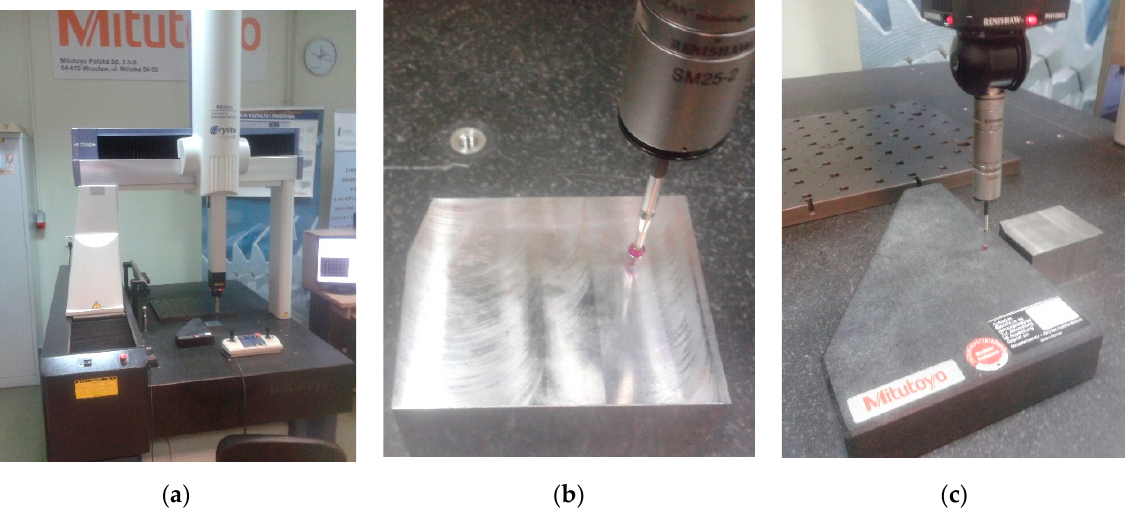
Figure 1. Experimental setup: ( a ) CMM Mitutoyo Crysta-Apex C7106; ( b ) Sample 1, steel machined by face milling; ( c ) Sample 2, granite standard of a right angle made by